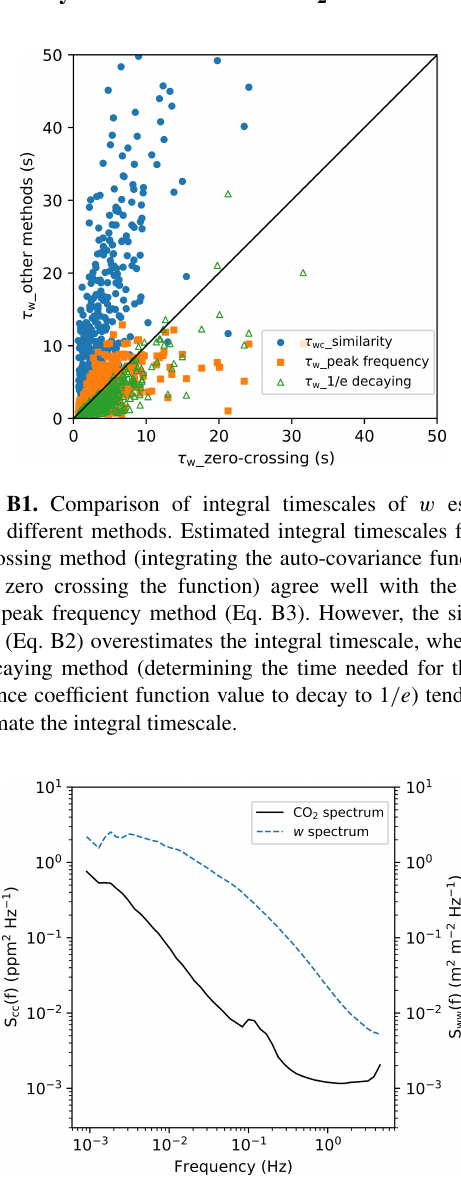
Figure B2. Mean variance spectra for CO 2 and w for one Arctic cruise JR18007. The near-constant CO 2 variance at high frequency (1–5Hz) indicates the band-limited noise in the CO 2 signal. In con- trast, the w spectrum does not show a similar band-limited noise at <